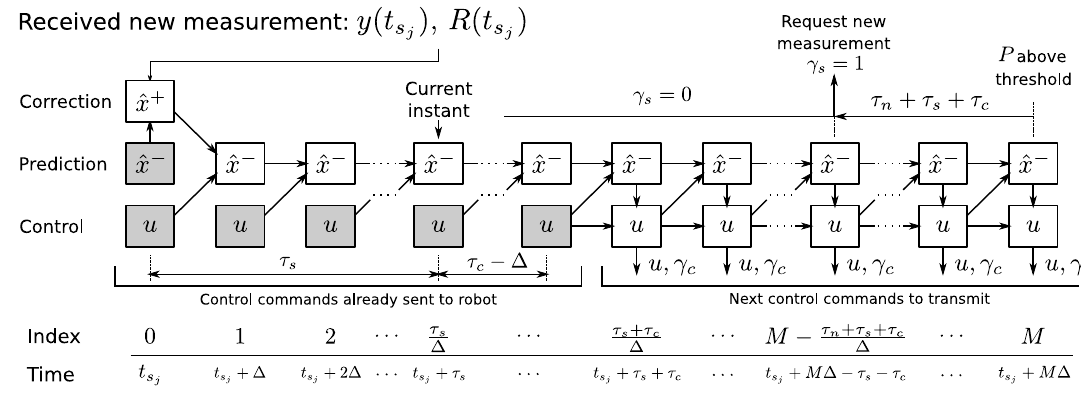
Figure 5. Table containing the computed estimation and control values.